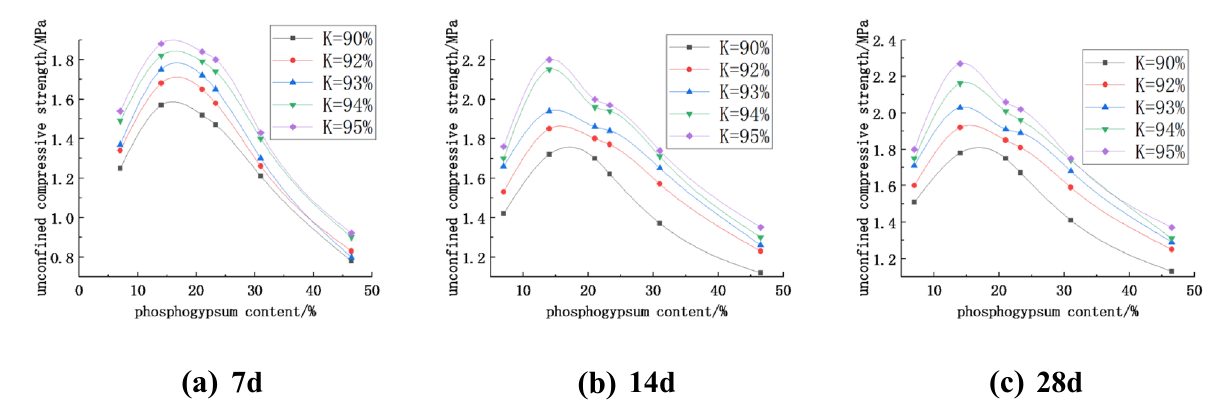
Fig. 3 Relationship curve between unconfined compressive strength and phosphogypsum content of mixture at different ages (7%